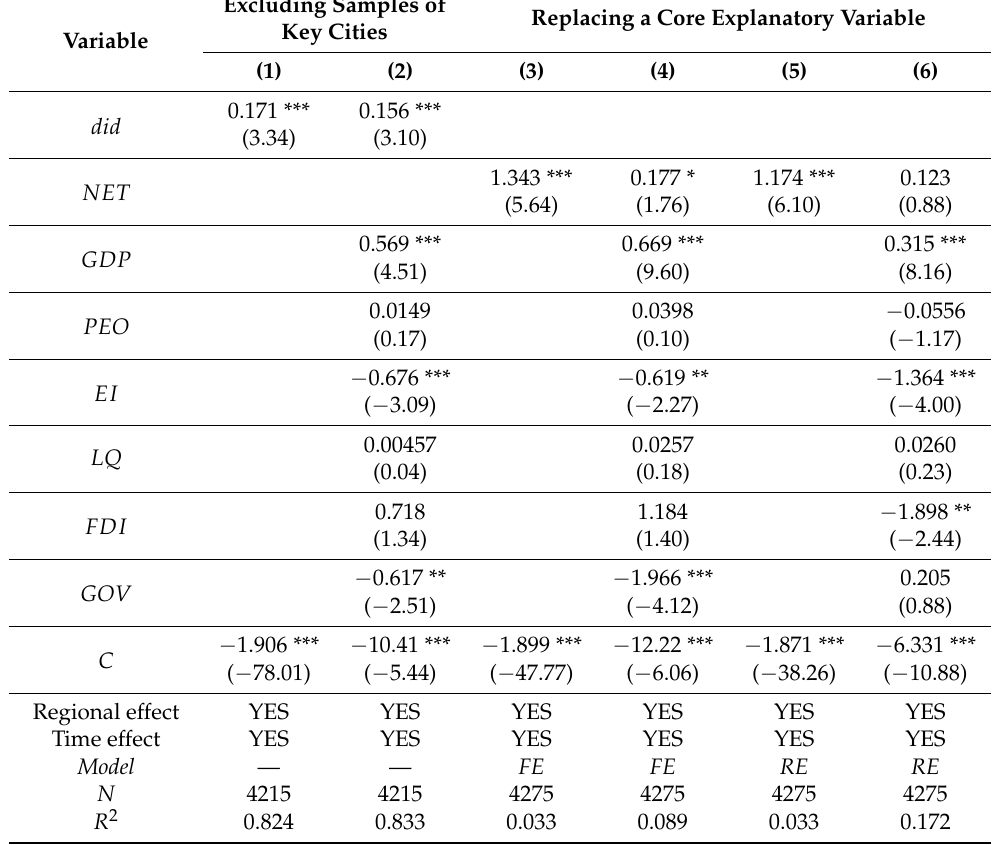
Table 5. Estimation results of models after excluding samples of key cities or replacing a core explanatory